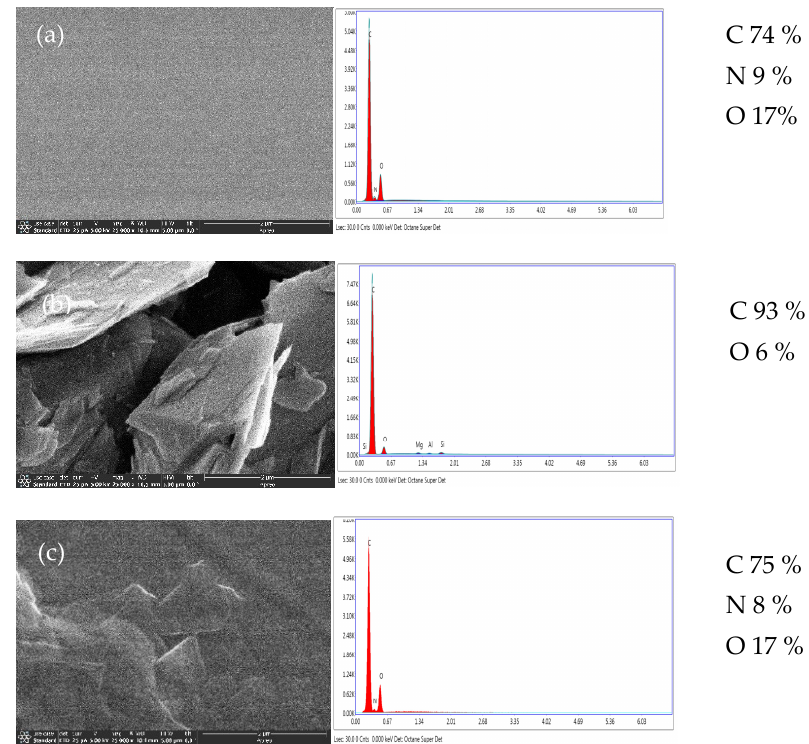
Figure 2. SEM images of ( a ) Neat PI, ( b ) Nano-graphene sheets and ( c ) PINGS-10 (×25,000) . At a higher magnification (×80,000), SEM images show coating of polyimide onto graphene. The images in Figure 3 indicate two regimes in the composites, the bulk polymer and the area surrounded by graphene. Graphene is shown to protrude out of the matrix. These observations are noteworthy as they explain the action of graphene in protecting the underlying polymer matrix from degradation.